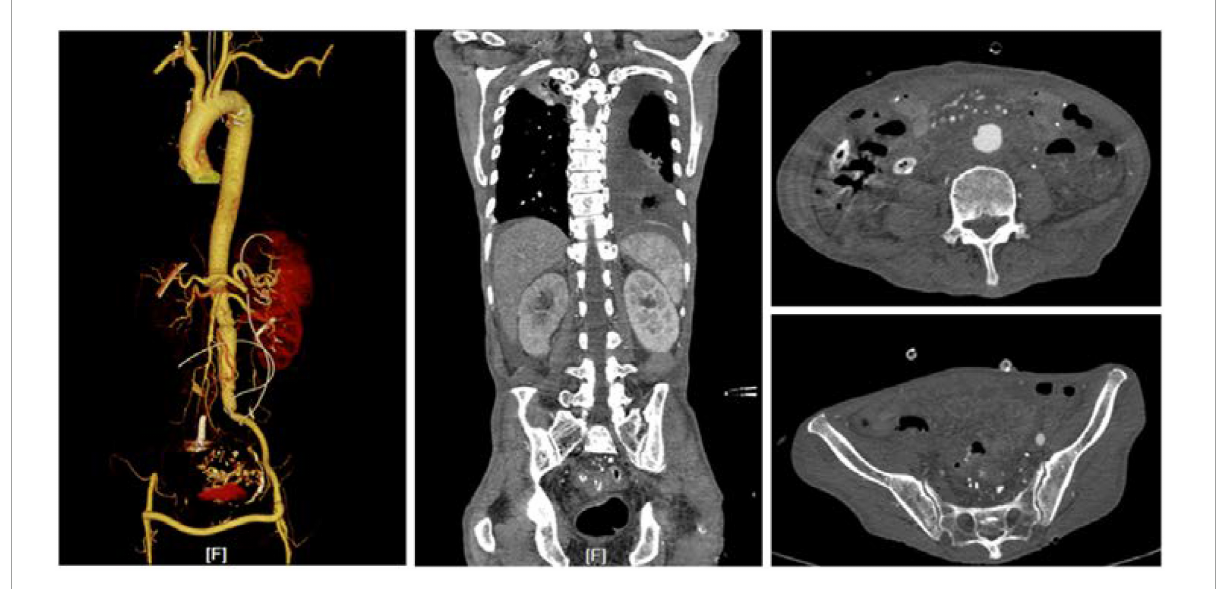
FIGURE3 CTA result at 1 month after the operation. Abscesses in the abdomen were cured. The bypass vessels and the lumen were unobstructed.